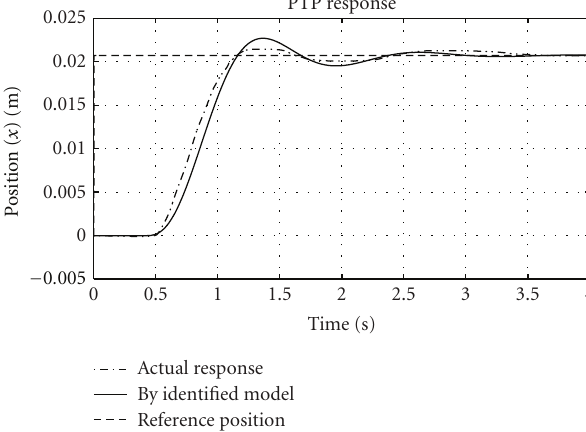
Figure 10: Comparison of PTP